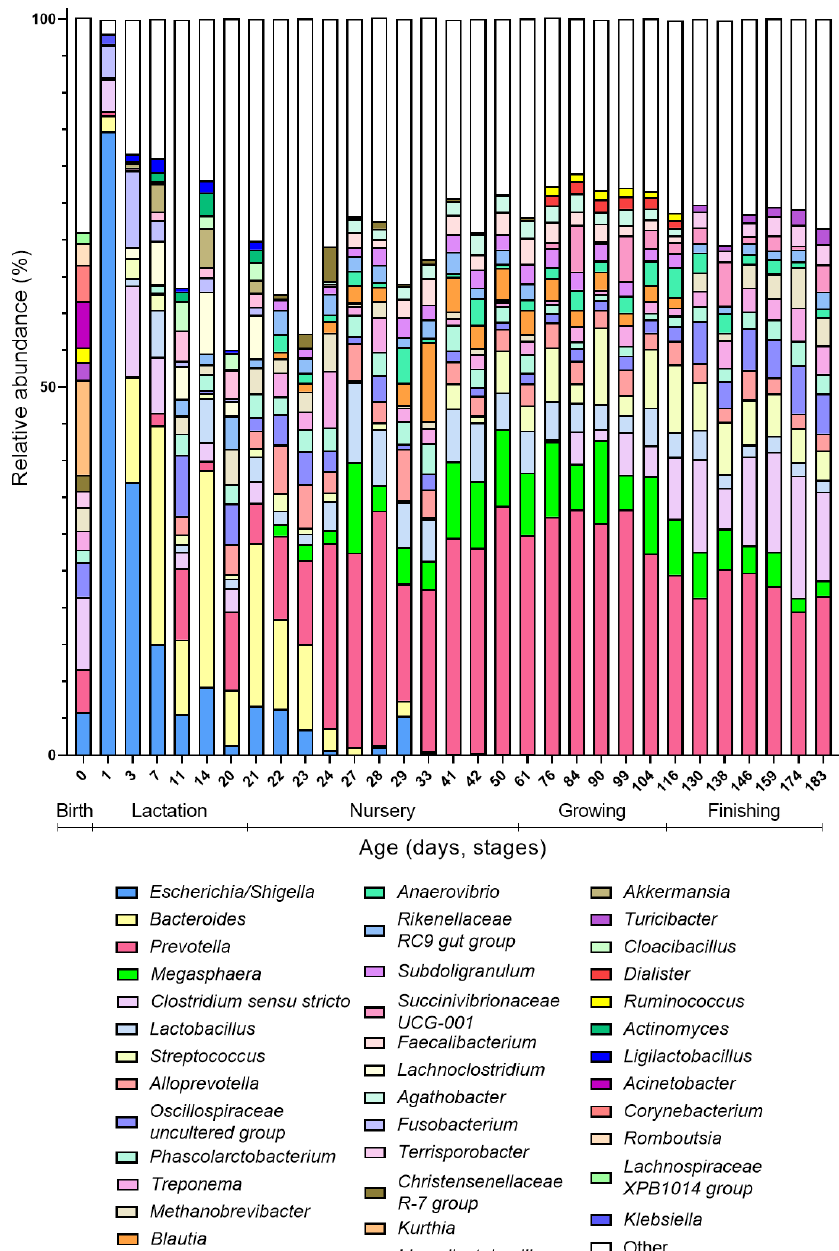
Figure 2. Taxonomic composition of the gut microbiota over time. Mean relative abundance (%) at genus level is plotted over time (day 0–day 183). Only the top 20 most abundant genera per growth stage with minimal 1% abundance were included in the graph. The different phases are indicated below the days on the x-axis (Birth: day 0, Lactation: days 1–21, Nursery: days 22–61, Growing: days 76–116 and Finishing: days